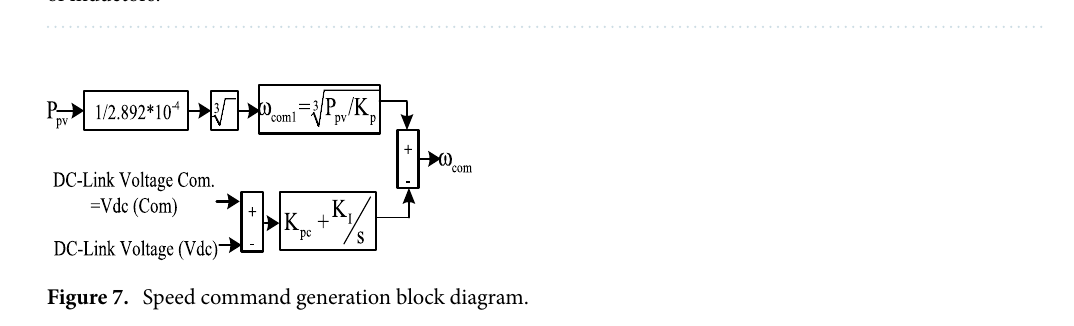
Table 2. Design of the converter parameters ns. where, f s is the switching frequency, (cid:31) I L is the ripple current of inductors.